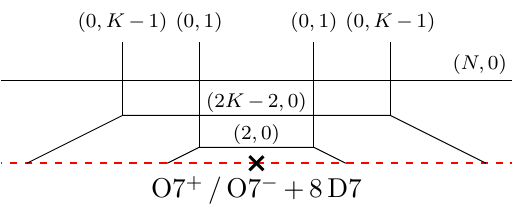
Figure 7. Gauge theory deformation of ? (cid:6) for j = 4 and M = 2 K even. For M odd there is N;M;j an additional NS5 on the O7, as in (cid:12)gure 4b. For N odd there is an unpaired D5 on the branch